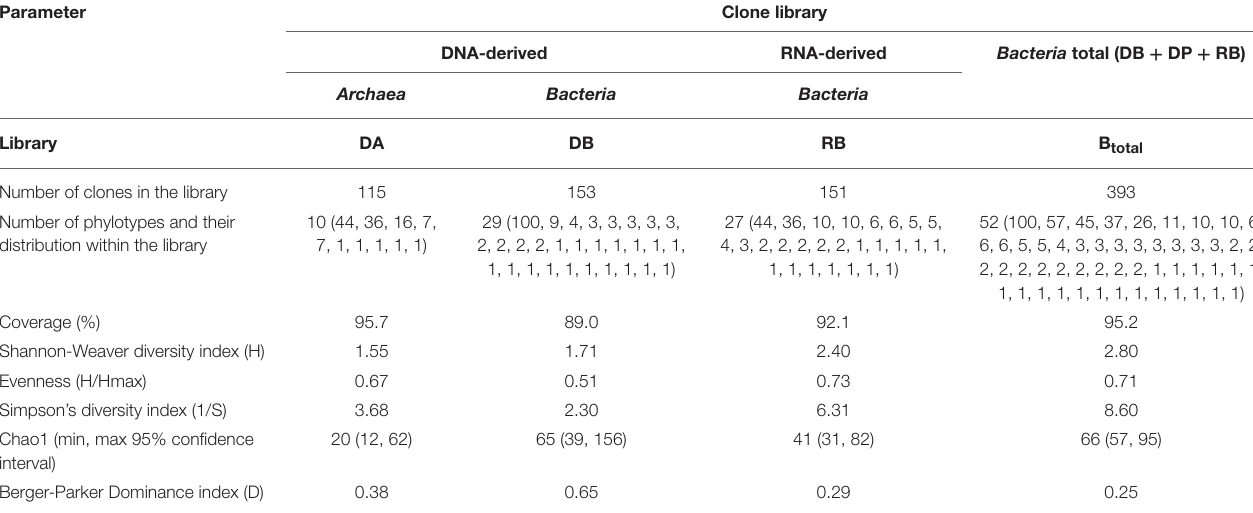
TABLE 2 | Diversity indices of the 16S rRNA gene sequences of Archaea and Bacteria and cDNA of 16S rRNA sequences of Bacteria in the clone libraries generated from DNA and RNA, respectively, of microorganisms of formation water from the high-temperature petroleum reservoir (December 2006).